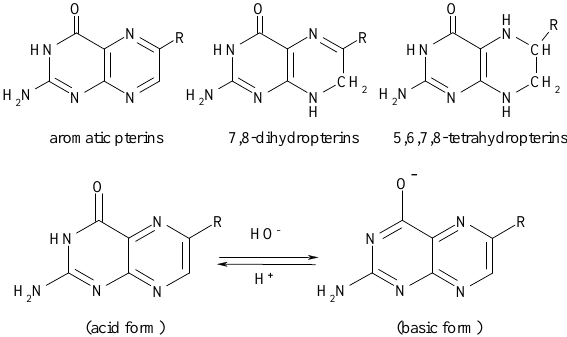
Figure 1. Molecular structures of pterin derivatives and the acid-base equilibrium in aqueous